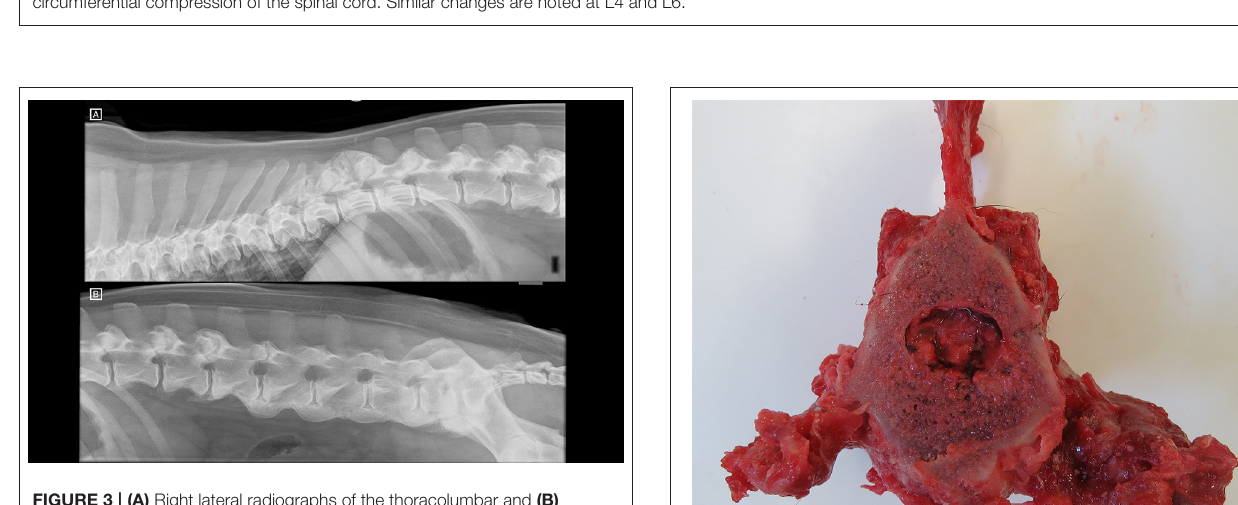
FIGURE 2 | Sagittal T1 weighted (A) pre and (B) post contrast MR images of the lumbar spine, and (C) corresponding subtraction image. (D) Transverse T1 weighted pre and (E) post contrast MR images at the level of mid-L5 and (F) corresponding subtraction image. Notice the diffuse hyperintensity, homogeneous enhancement of the vertebral structures, associated with circumferential concentric bone thickening, and secondary narrowing of the vertebral canal (white arrows) leading to circumferential compression of the spinal cord. Similar changes are noted at L4 and L6.